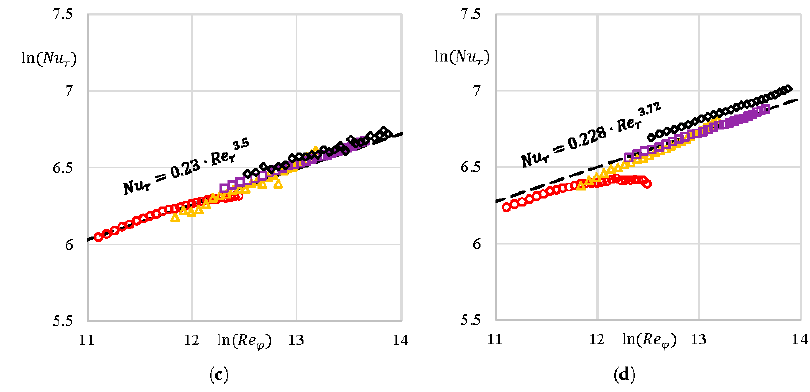
Red: 𝜍 = 20% , 𝑅𝑒 = 0.22 × 10 (cid:2874) , Orange: 𝜍 = 50% , 𝑅𝑒 = 0.55 × 10 (cid:2874) , Purple: 𝜍 = 80%,𝑅𝑒 = 0.88 × 10 (cid:2874) , Black: 𝜍 = 100%,𝑅𝑒 = 1.11 × 10 (cid:2874) Figure 10. Variations of ln (𝑁𝑢 (cid:3045) ) versus ln (𝑅𝑒 (cid:3101) ) by measurements: ( a ) 𝐶 (cid:3050) = 1262 ; ( b ) 𝐶 (cid:3050) = 2525 ; Figure 10. Variations of ln ( Nu r ) versus ln ( c ) 𝐶 (cid:3050) = 3787 and ( d ) 𝐶 (cid:3050) = 5050 . C w = 3787 and ( d ) C w = 5050.